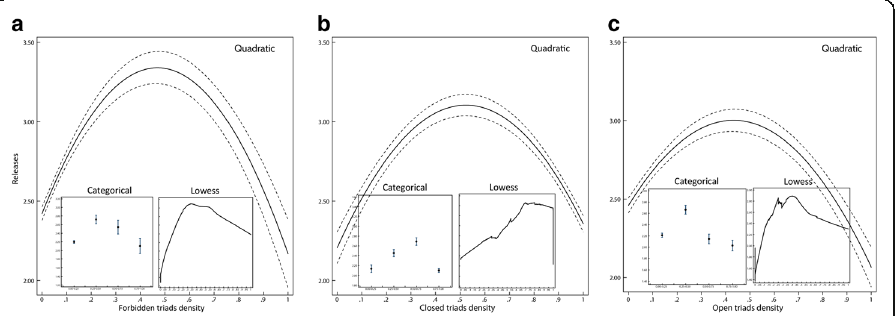
categorical and lowess estimators for: a Forbidden triads density; b Closed triads density; c Open triads